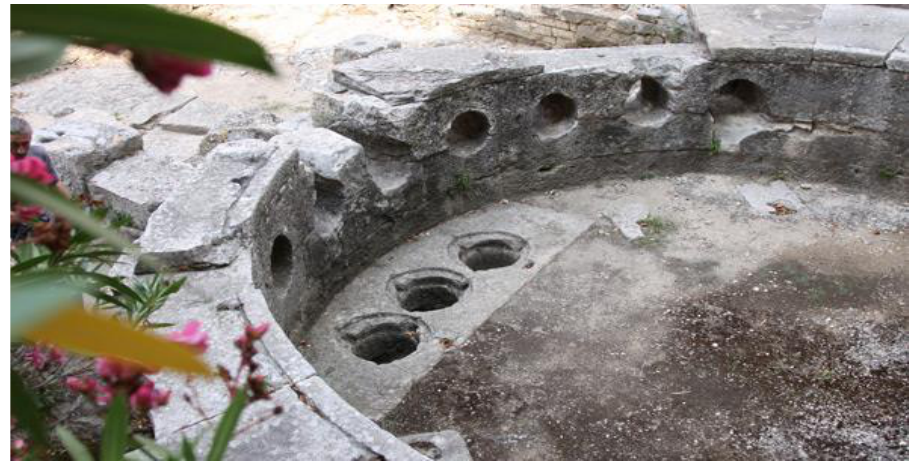
Figure 36. Interior view of the Pont du Gard water distribution castellum. Photo by author.